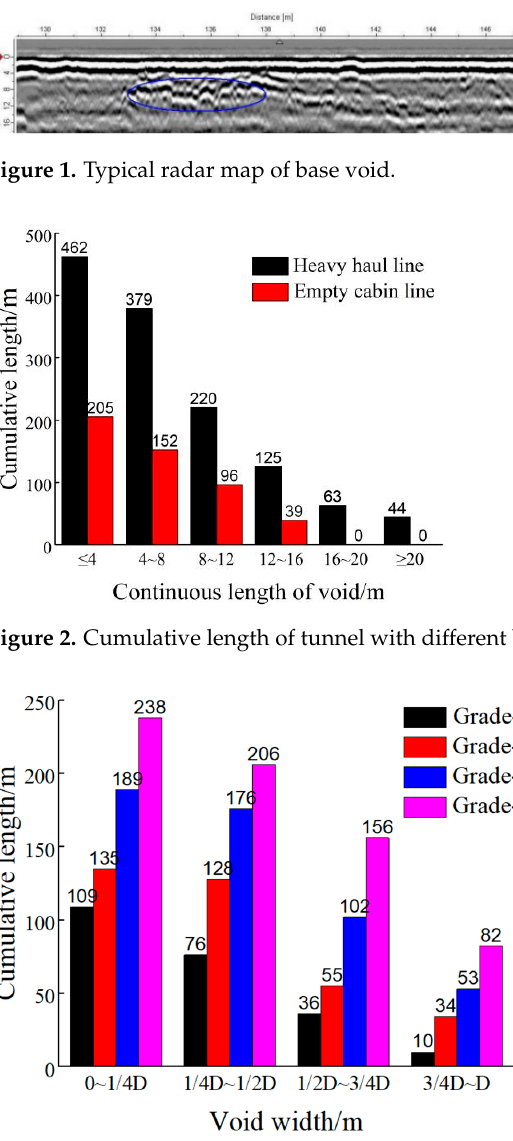
Figure 1. Typical radar map of base void.